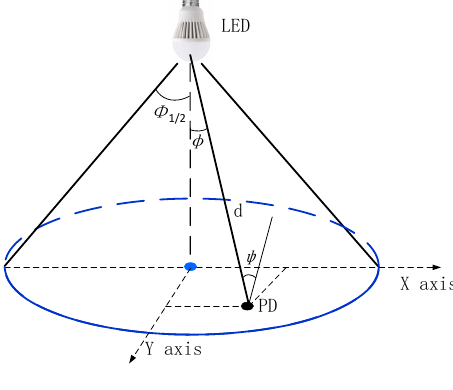
Figure 1. Optical channel